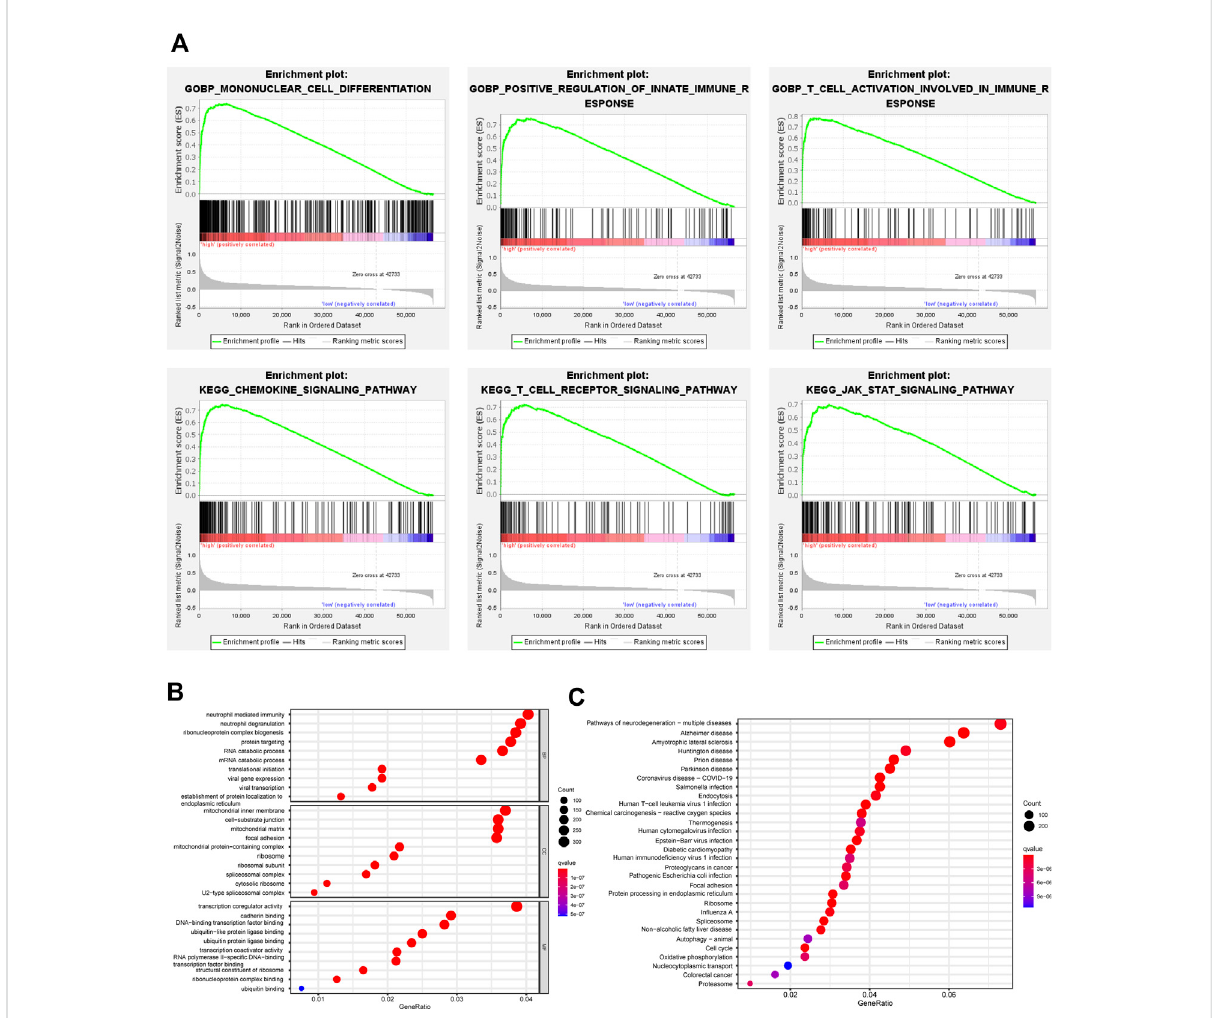
FIGURE 7 Functional analysis of GBP5 inCRC (A) GSEA identi fi esdifferentgene sets between high and low expressiongroups of GBP5. The mononuclear cell differentiation (NES = 2.68, p-val = 0.00, FDR q-val = 0.00), the positive regulation of innate immune response (NES = 2.60, p-val = 0.00, FDR q-val = 0.00), the T cell activation involved in immune response (NES = 2.58, p-val = 0.00, FDR q-val = 0.00), the chemokine signaling pathway (NES = 2.53, p-val = 0.00, FDR q-val = 0.00), the T cell receptor signaling pathway (NES = 2.55, p-val = 0.00, FDR q-val = 0.00), and the